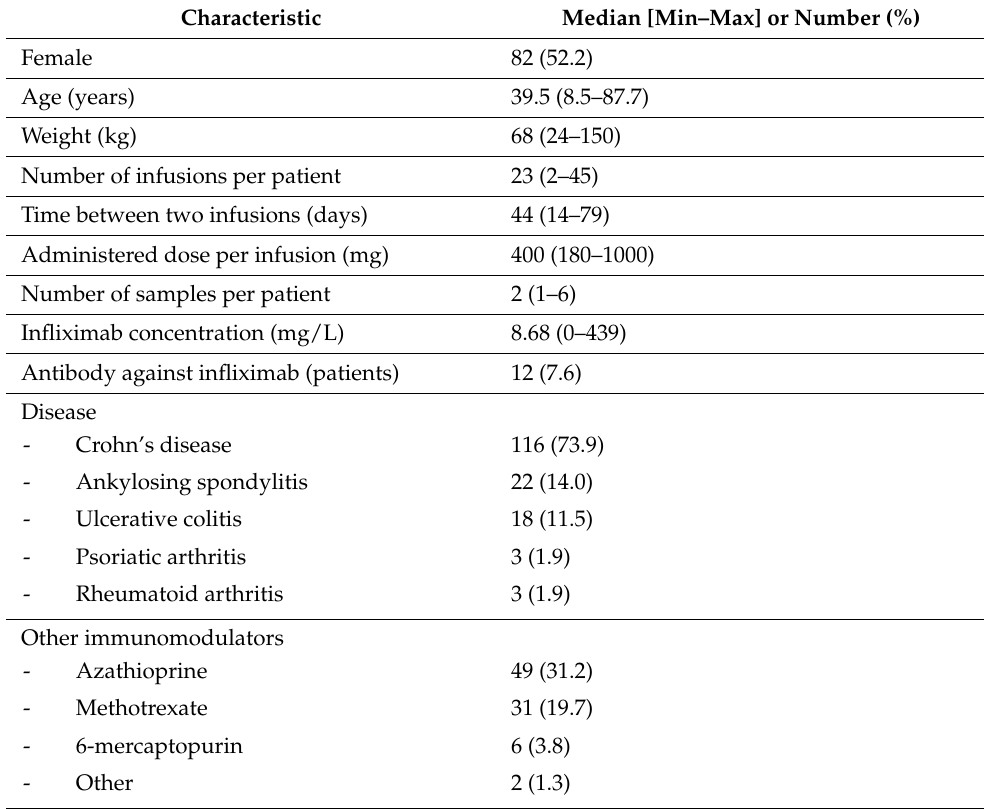
Table 2. Baseline patients’ characteristics of the external evaluation